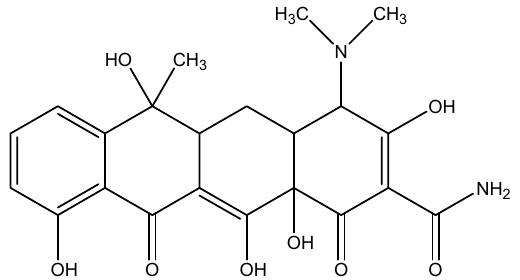
Figure 1. Chemical structure of tetracycline.